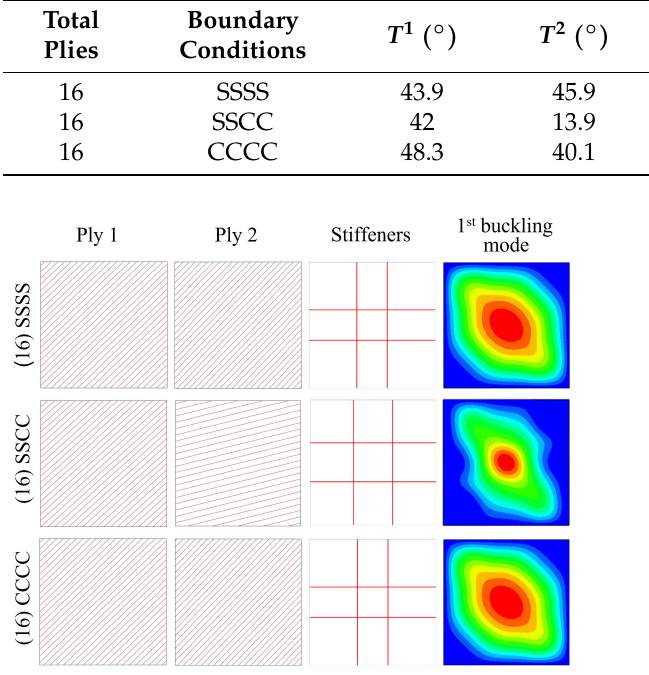
Figure 11. Optimized straight fiber panels subjected to biaxial compression plus shear.